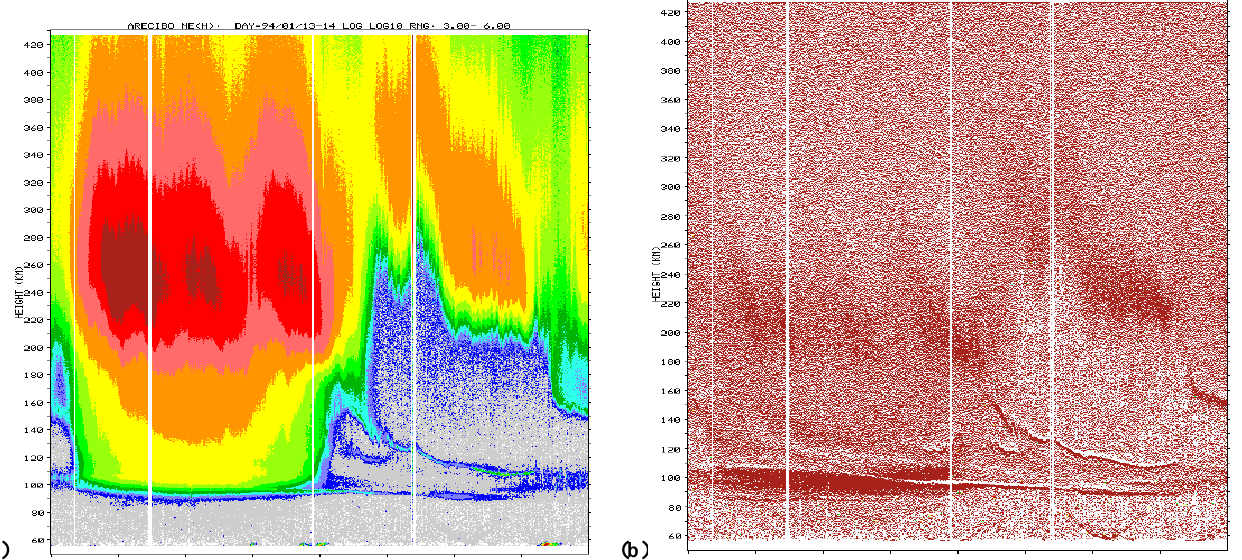
Fig. 2. Example of different presentation of the measured electron density profiles by the Arecibo ISR during a period of 24h starting at 06:00LT (ordinate axis). The left panel is the usual log N e height-time-intensity (HTI) plot whereas in the right panel is the log (dN e /dz) plot used for the purposes of the present